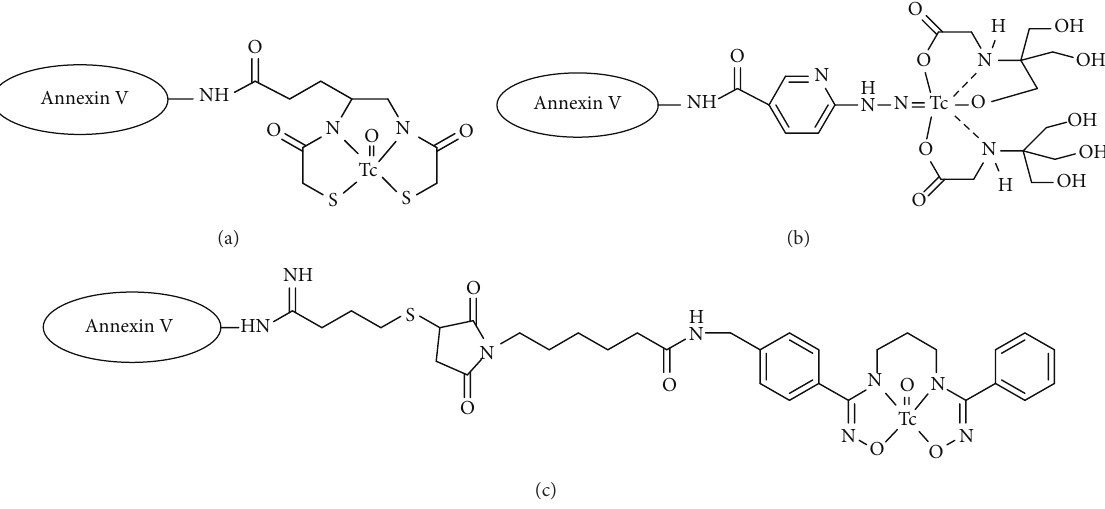
Figure 1: Structures of (a) 99 m Tc-BTAP-annexin V, (b) 99 m Tc-HYNIC-annexin V, and (c) 99 m Tc-C 3 (BHam) 2 -annexin